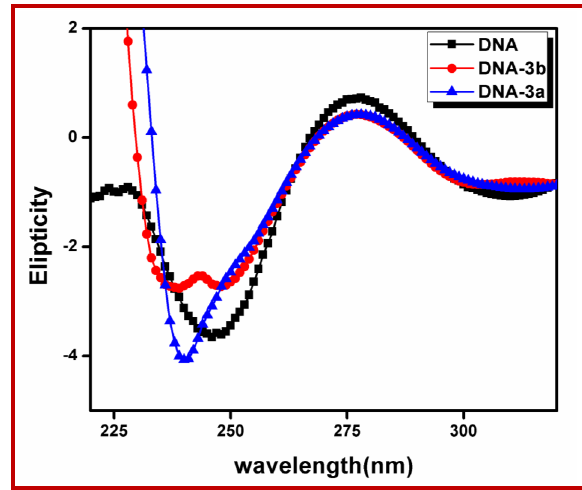
Figure 3: CD spectra of Ct-DNA (50 mM) in the absence and presence of the compounds 3a and 3b (50 mM), in 5 mM phos- phate buffer